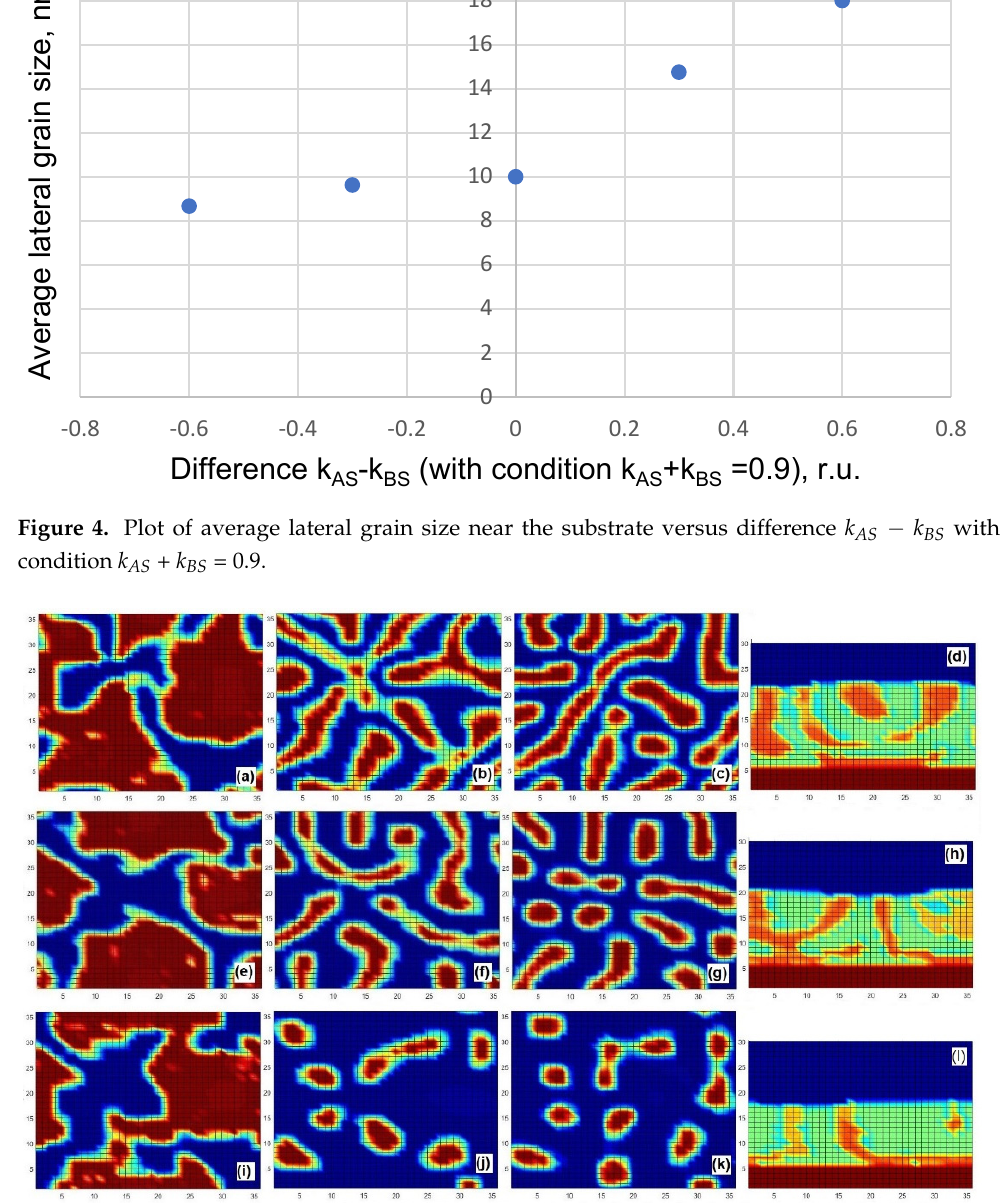
Figure 5. Horizontal cross sections through the planes z = 6 ( a , e , i ), z =12 ( b , f , j ), and z = 18 ( c , g , k ) and vertical cross sections through the planes x = 25 ( d ), x = 15 ( h ), and y = 25 ( l ) obtained with the following sticking coefficients: k AA = 0.75, k AB = 0.75 ( a – d ), k AA = 0.5, k AB = 0.5 ( e – h ), k AA = 0.25, and k AB = 0.25 ( i , j , k , l ).